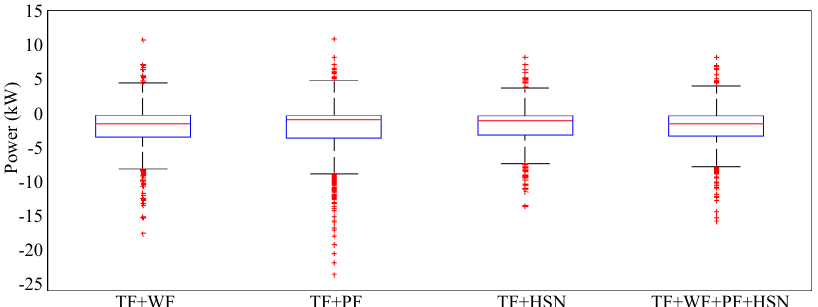
Figure 23. Box-whisker plot of response errors under multiple sorting criterion.